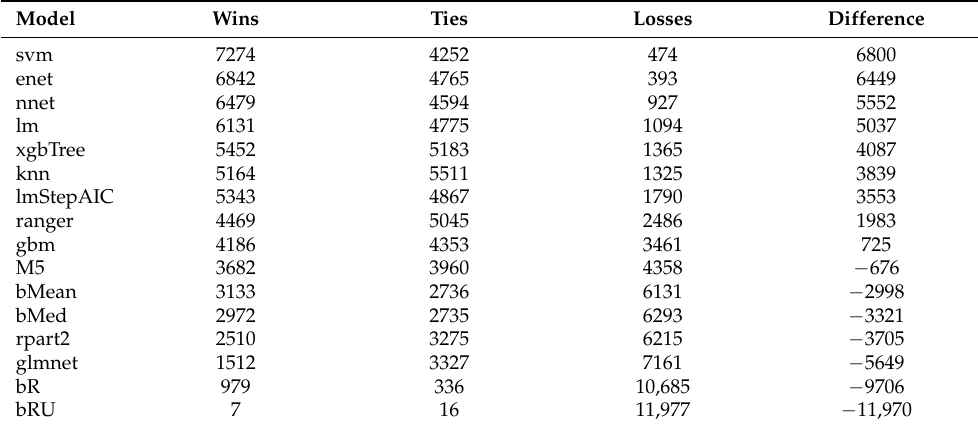
Table 5. Summary of model